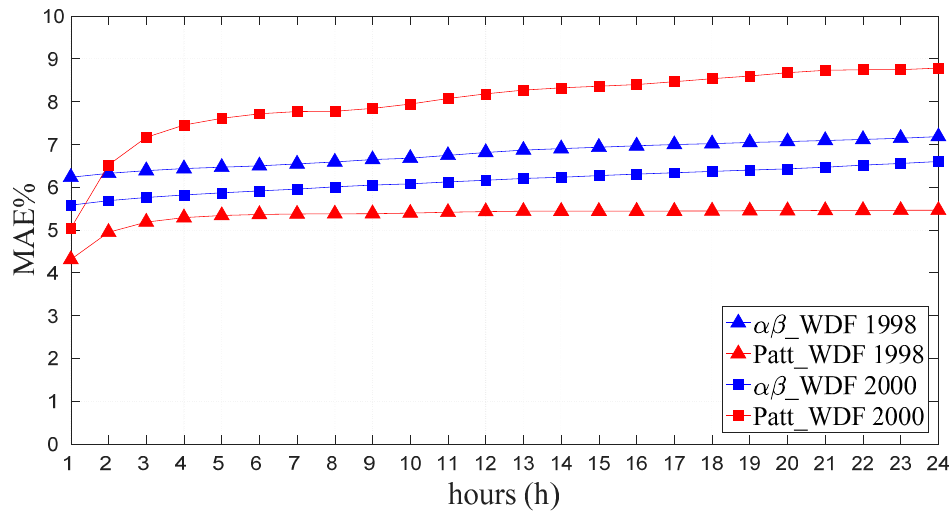
Figure 3. Mean Absolute Error (MAE%) of the αβ _WDF and Patt_WDF models for the years 1998 and 2000 for different forecasting time horizons.